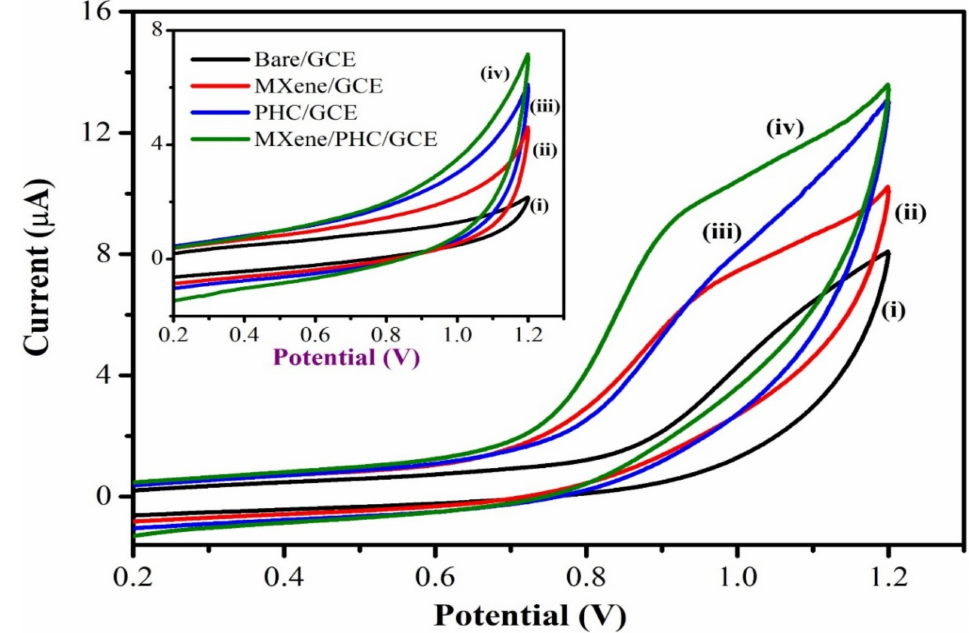
Figure 7. CVs were recorded in 0.1 M phosphate buffer (pH 7.4) with 0.3 mM of NIC using ( i ) bare/GCE, ( ii ) MXene/GCE, ( iii ) PHC/GCE and ( iv ) MXene/PHC/GCE at a scan rate of 50 mV s − 1 . Inset: CVs of each electrode in 0.1 M phosphate buffer (pH 7.4) without NIC.